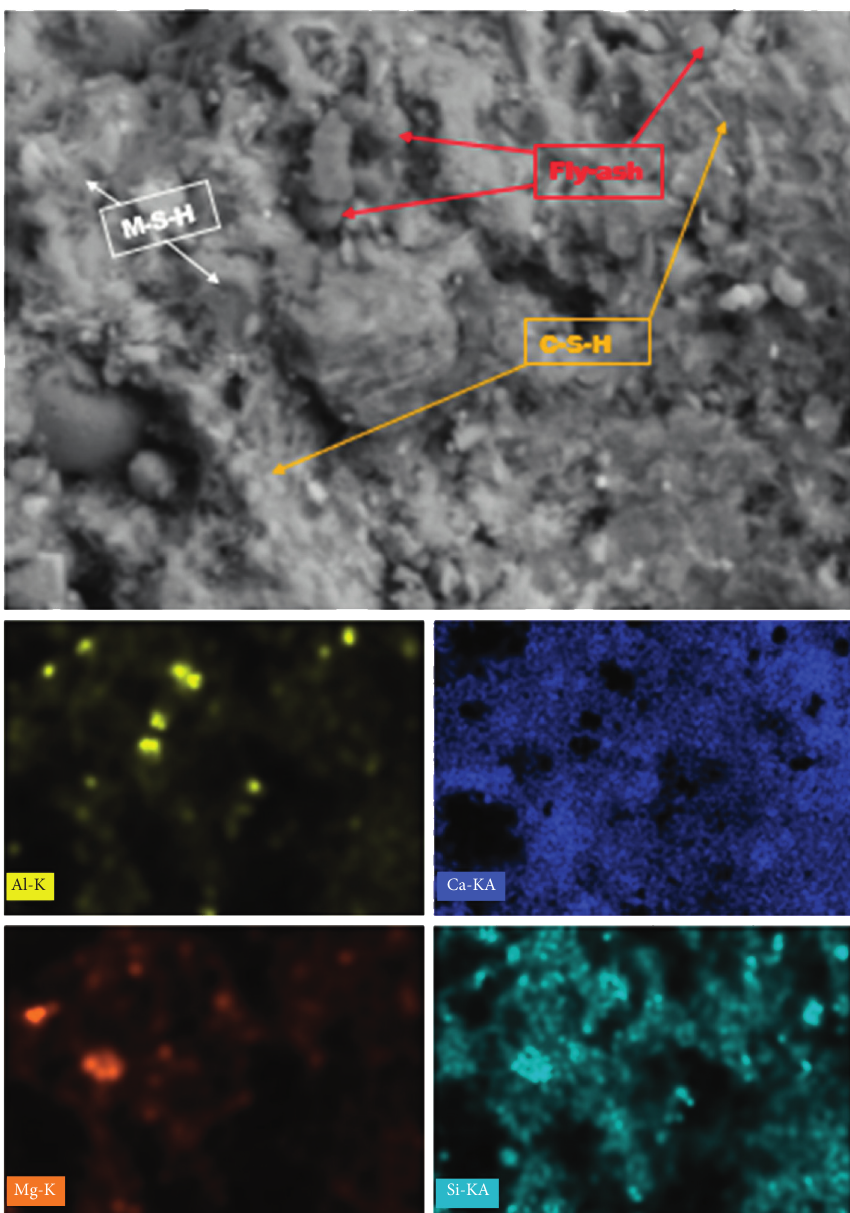
Figure 11: SEM image and corresponding EDX mapping for Al, Ca, Mg, and Si in